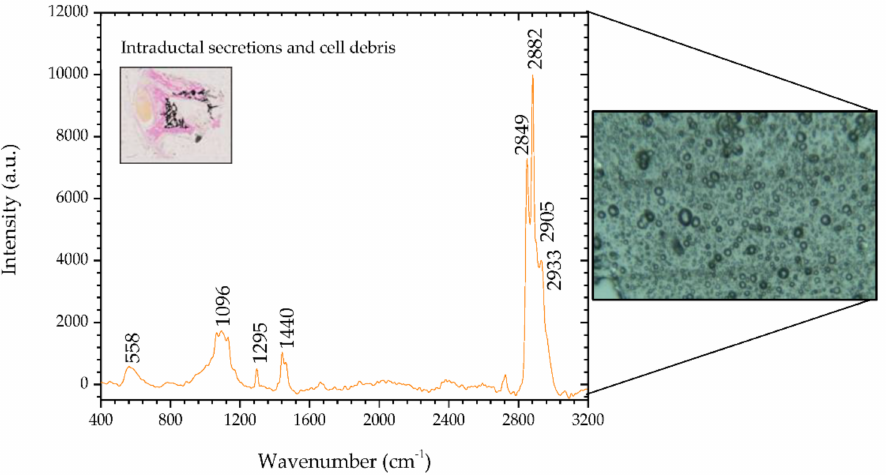
Figure 3. Raman spectra of intraductal secretions and cellular debris in ectasia duct areas in sample #1 and, on the right side, the corresponding microscopic image (50 × , Raman spectrometer system). The inset shows a microscopic image (2.5 × ) of intraductal secretions and cellular debris stained orange by means of the Von Kossa-Van Gieson modified method.